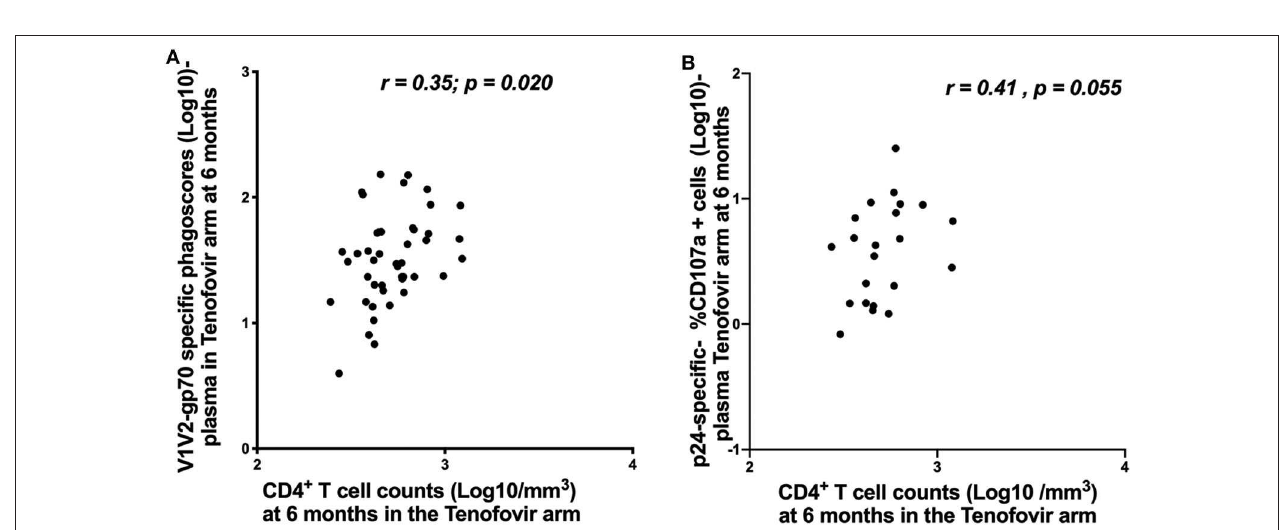
FIGURE 7 | Correlations between CD4 + T cell counts and ADNP (Log 10 Phagoscores) and NK cell activated ADCC in the plasma for the tenofovir arm at 6 months. (A) V1V2-gp70-specific phagoscores (Log10) correlation with CD4 + T cell counts and (B) p24-specific- %CD107a + cells (Log10]) correlation with CD4 + T cell counts. Significant values were identified as p <